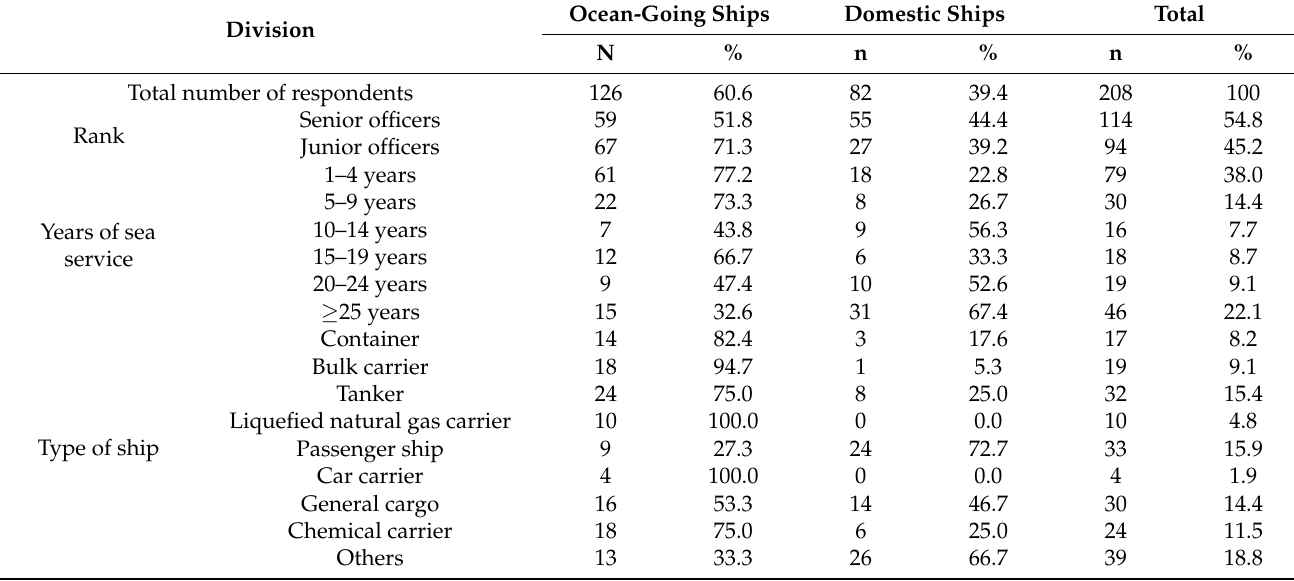
Table 6. Respondents’ general characteristics (Source: adopted from